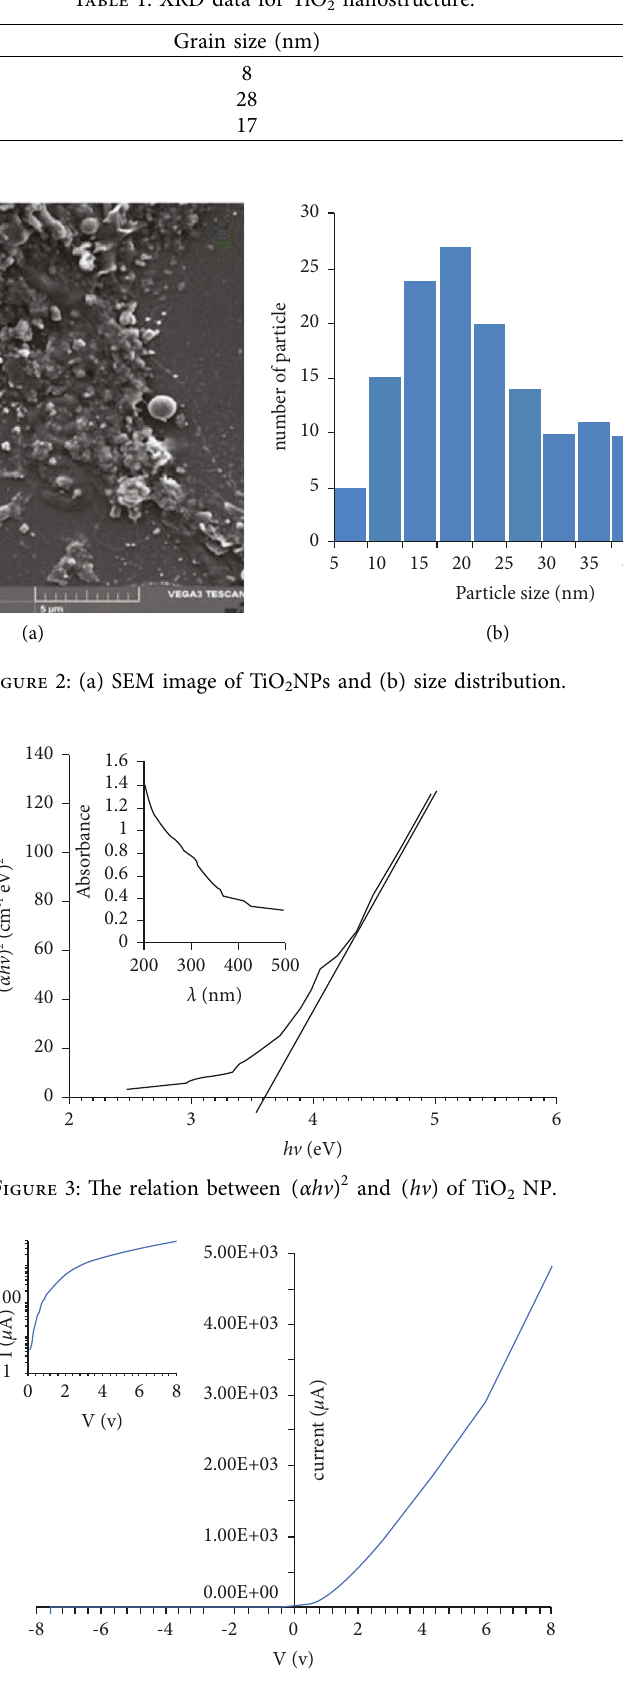
Table 1: XRD data for TiO